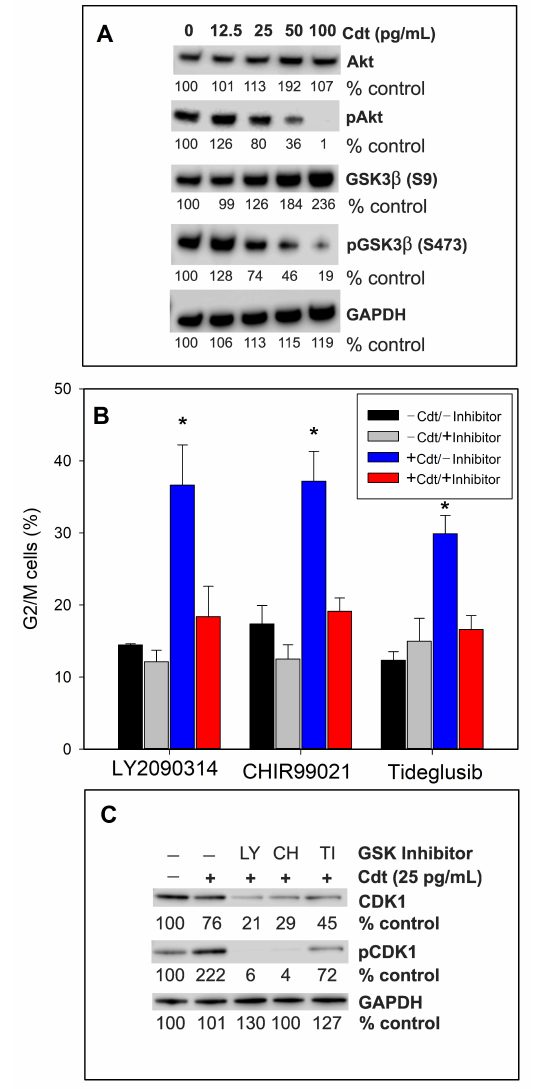
Figure 6. GSK3 β activation is critical to Cdt-induced cell cycle arrest. Panel ( A ) shows representative results of PGKs treated with varying amounts of Cdt for 6 h. Cell lysates were monitored by Western blot for the levels of Akt, pAkt, GSK3 β and pGSK3 β . GAPDH is shown as a gel loading control. Results are representative of three experiments. Panel ( B ) shows the effects of TIGK pre-treatment with the GSK3 β inhibitors, 10 µ M LY2090314, 25 µ M CHIR99021 or 25 µ M Tideglusib for 60 min followed by the addition of Cdt (2 pg/mL). Cells were analyzed at 24 h for cell cycle arrest (G2/M accumulation). Data are plotted as the percentage (mean ± SEM) G2/M cells from three experiments; black bars represent untreated cells, grey bars cells exposed to inhibitor only, blue bars cells exposed to Cdt only and red bars cells pre-exposed to inhibitor followed by Cdt. * indicates statistical significance ( p < 0.05) when compared to cells treated with Cdt only. Panel ( C ) shows the effect of three GSK inhibitors, LY2090314 (LY), CHIR99021 (CH) or Tideglusib (TI), on CDK1 and pCDK1 levels in TIGK cells. Cells were treated as described above and analyzed by SDS-PAGE and Western blot at 24 h. Representative (of four experiments) blots are shown; numbers represent the levels of protein expression as a percentage of control cell (untreated) content. GAPDH is shown as a gel loading